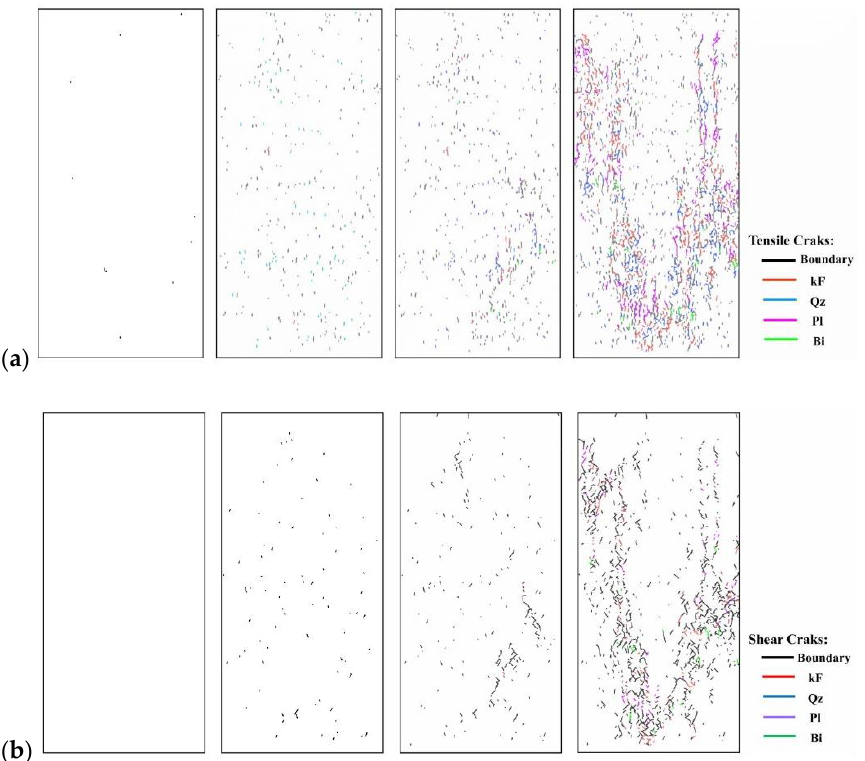
Figure 15. Crack distribution diagrams of transgranular cracks (kF, Qz, Pl, Bi) and Boundary cracks at four stress values of σ ci , σ cd , σ peak and σ pcd during the crack evolution. ( a ) Tensile failure ( b ) Shear failure.